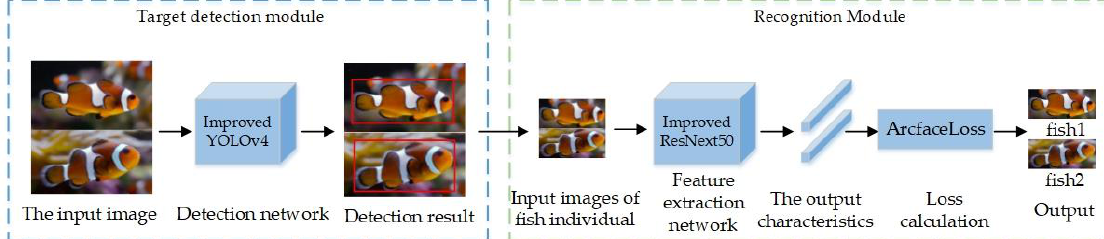
Figure 2. The diagram of the model’s structure.